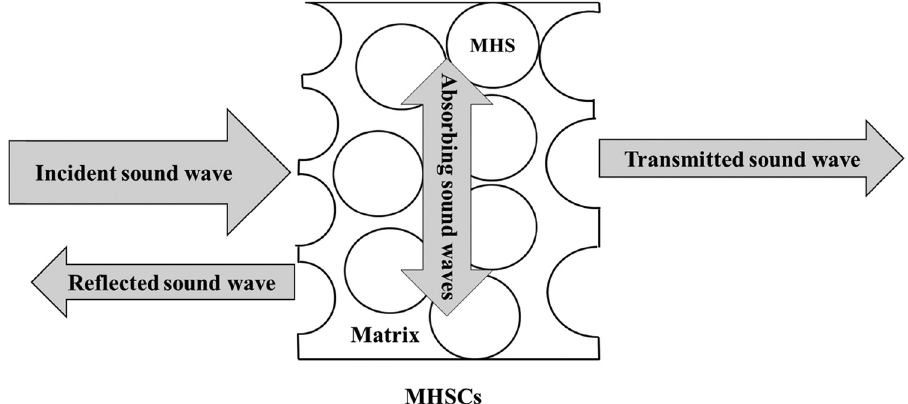
Figure 7: The sound absorption mechanism schematic diagram of